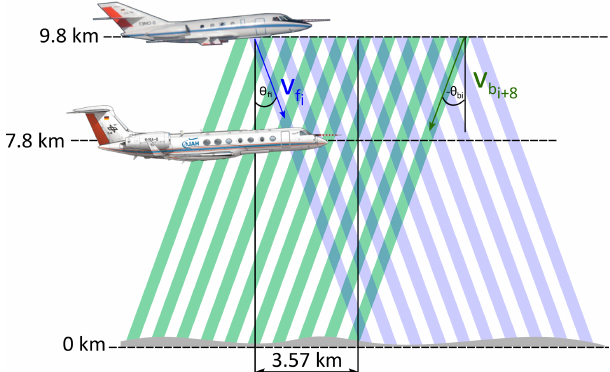
Figure 3. Schematic illustration of the scan procedure applied when operating in MF mode to retrieve profiles of the horizontal wind along flight direction u par and the vertical wind w ,